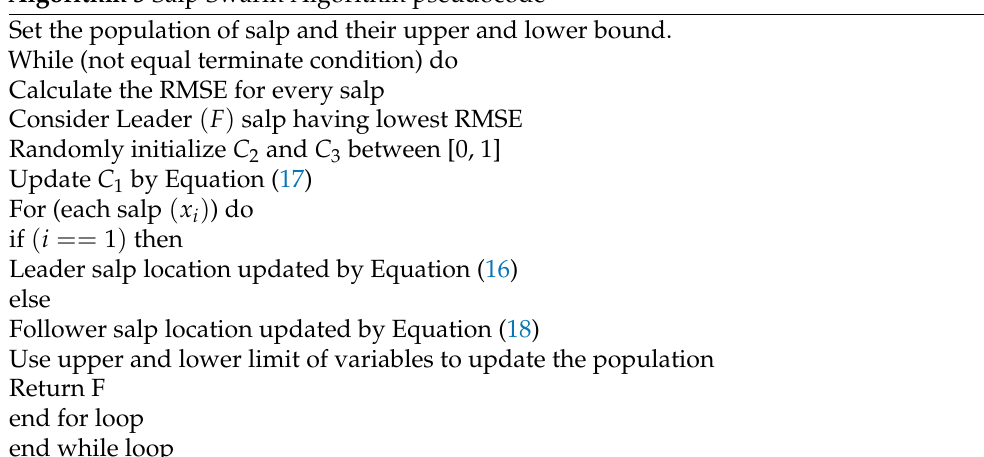
Algorithm 3 Salp Swarm Algorithm